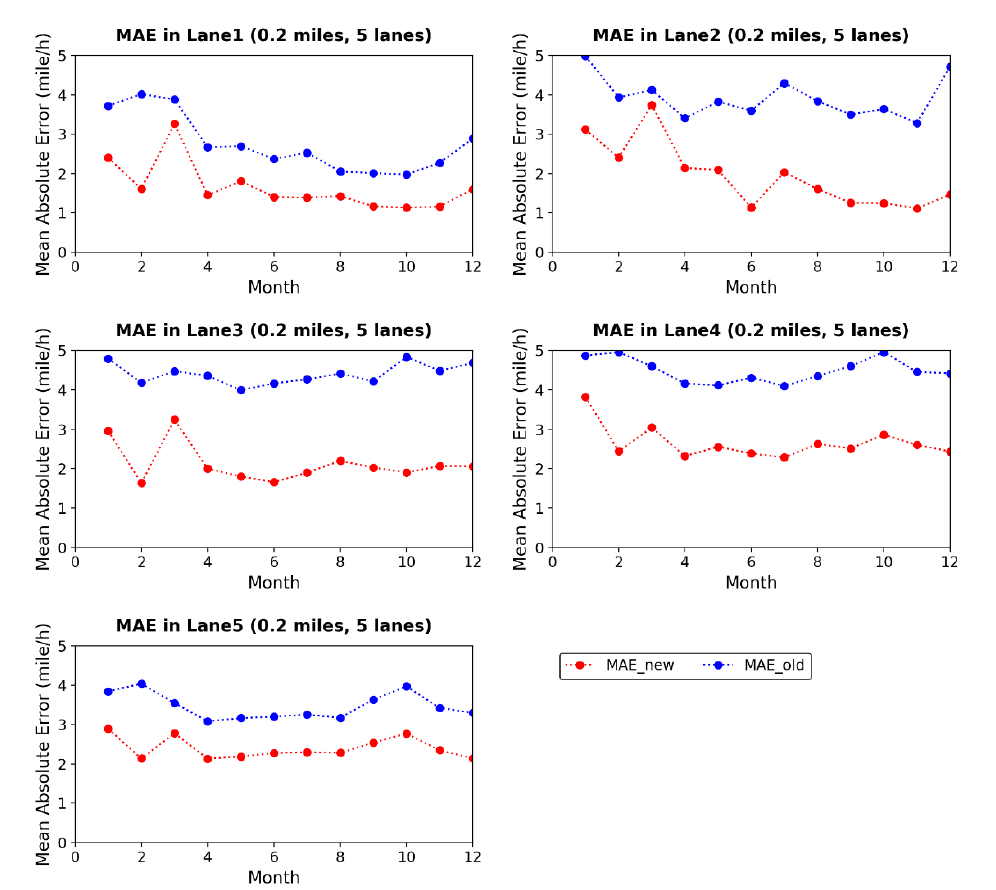
Figure 7. MAE curves of the new system and the old system in segment {0.2 miles, 5